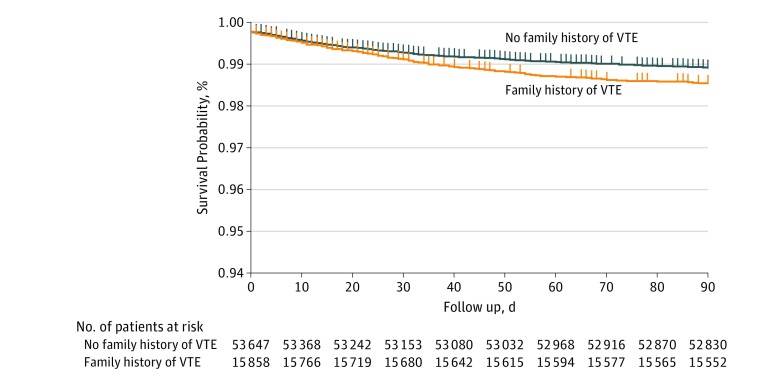
Thrombosis-Free Kaplan-Meier Survival Curves for Patients With and Without a Family History of Venous Thromboembolism (VTE)The probability to be diagnosed with VTE during the study period was higher for patients with a family history of VTE than no family history of VTE (P < .001).